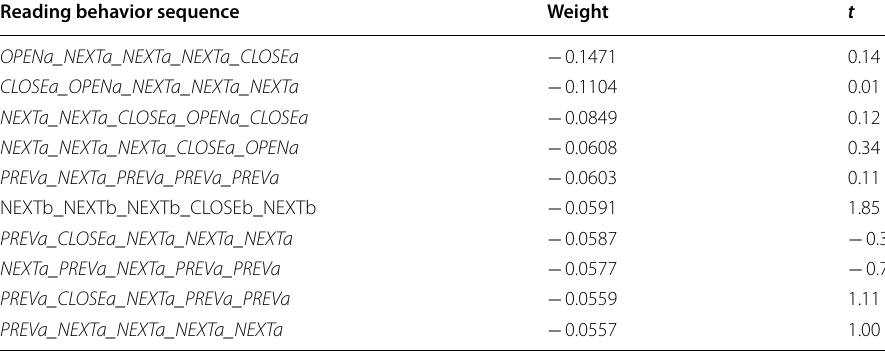
Table 9 Characteristic reading behaviors of low performing learners